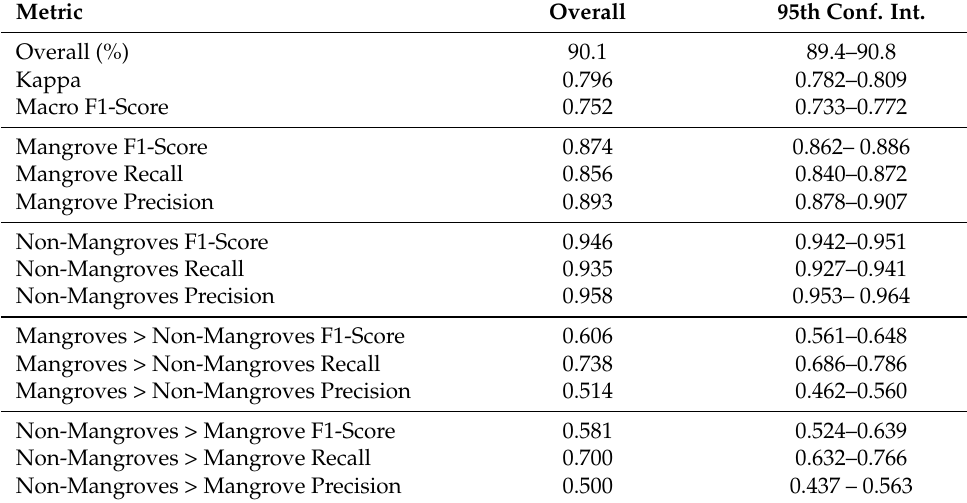
Table 8. Results of the accuracy assessment of the GMW v3.0 change